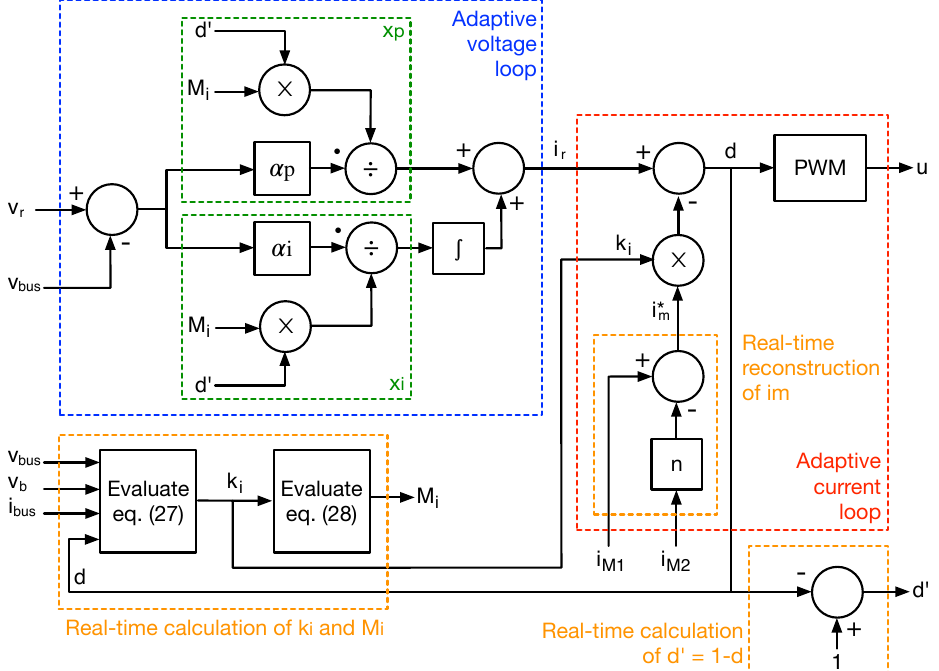
Figure 5. Implementation of the double-adaptive control